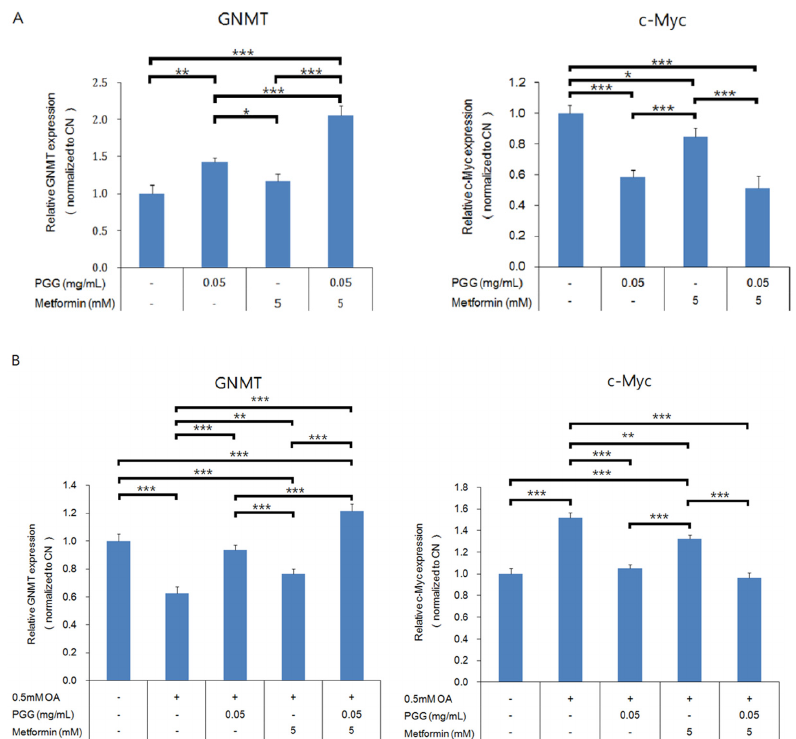
Figure 3. The GNMT-related gene expression in Mahlavu cells. Gene expression of GNMT and c-Myc without oleic acid ( A ) and with oleic acid ( B ). (* p < 0.05; ** p < 0.01; *** p < 0.001; N = 3/group).